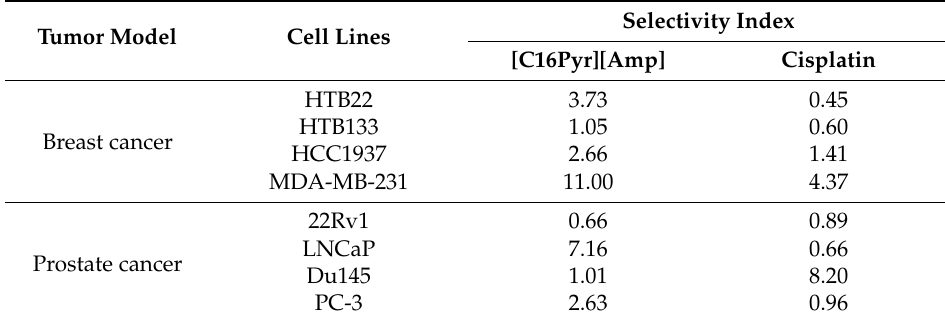
Table 2. Selectivity index (SI) of [C16Pyr][Amp] and cisplatin for each breast (BrCa) and prostate (PCa) cancer cell